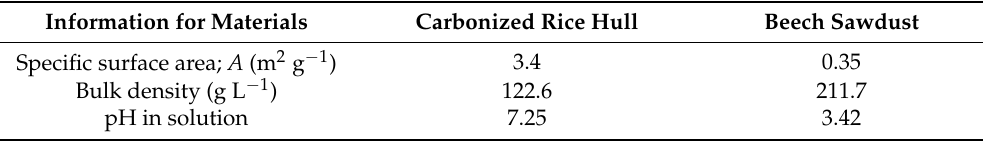
Figure 1. SEM images illustrating the surface morphology of the natural materials used in this study; ( a ) carbonized rice hull and ( b ) beech sawdust. Table 1. Information for carbonized rice hull and beech